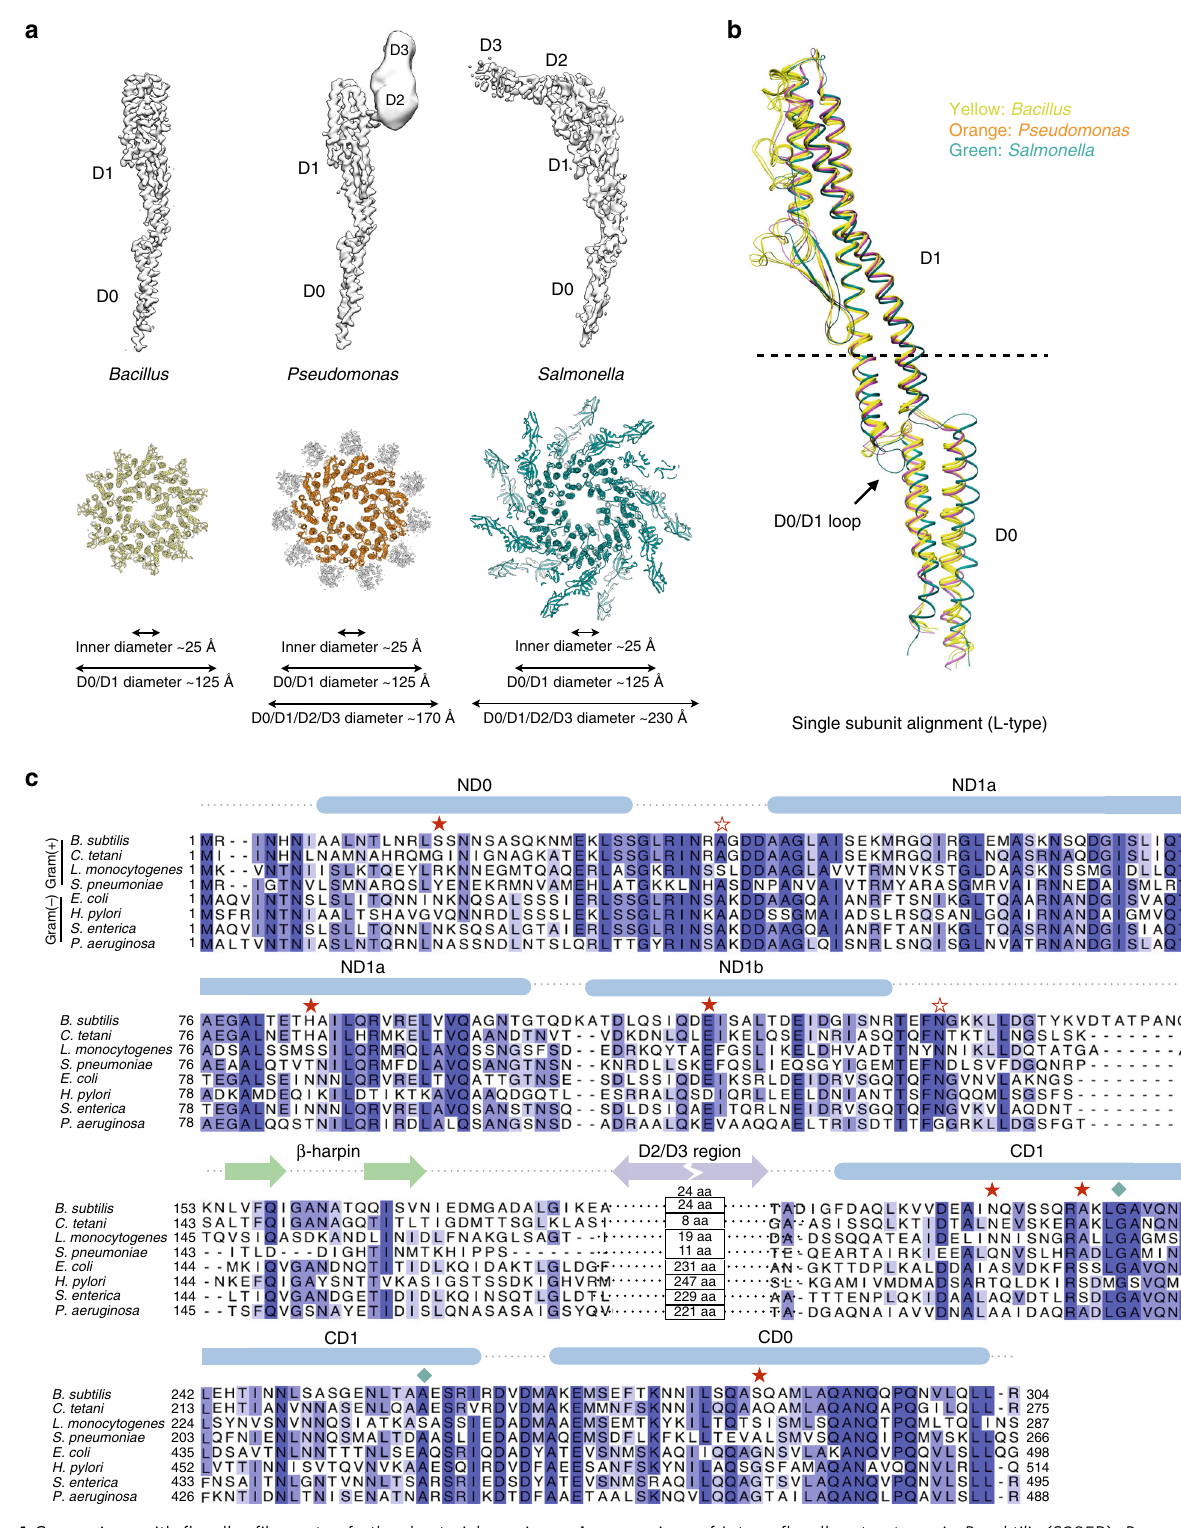
Fig. 4 Comparison with fl agellar fi laments of other bacterial species. a A comparison of L-type fl agellar structures in B. subtilis (S285P), P. aeruginosa (G420A) and S. enterica (PDB: 3A5X, EMD-1641). A comparison of the segmented maps corresponding to a single subunit is shown on top. A diameter comparison from the top view of the fi laments is shown on the bottom . b Superimposition of the single L-type subunits: three from B. subtilis ( yellow , S285P, S17P, E115G), one from P. aeruginosa ( orange , G420A) and one from S. enterica ( dark green , 3A5X). The dashed line indicates where the crystal structure of S. enterica ends. c Alignments of the fl agellin amino acid sequence from four gram-positive bacteria and four gram-negative bacteria. Single mutants in B. subtilis are marked with fi lled red stars , the double mutants are marked with empty red stars , and the mutants in P. aeruginosa are marked with fi lled blue